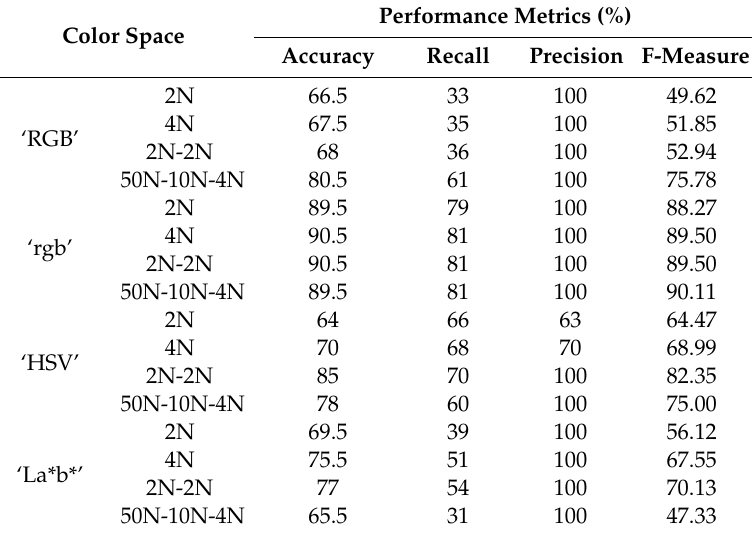
Table 3. Performance metrics of various MLP configurations.